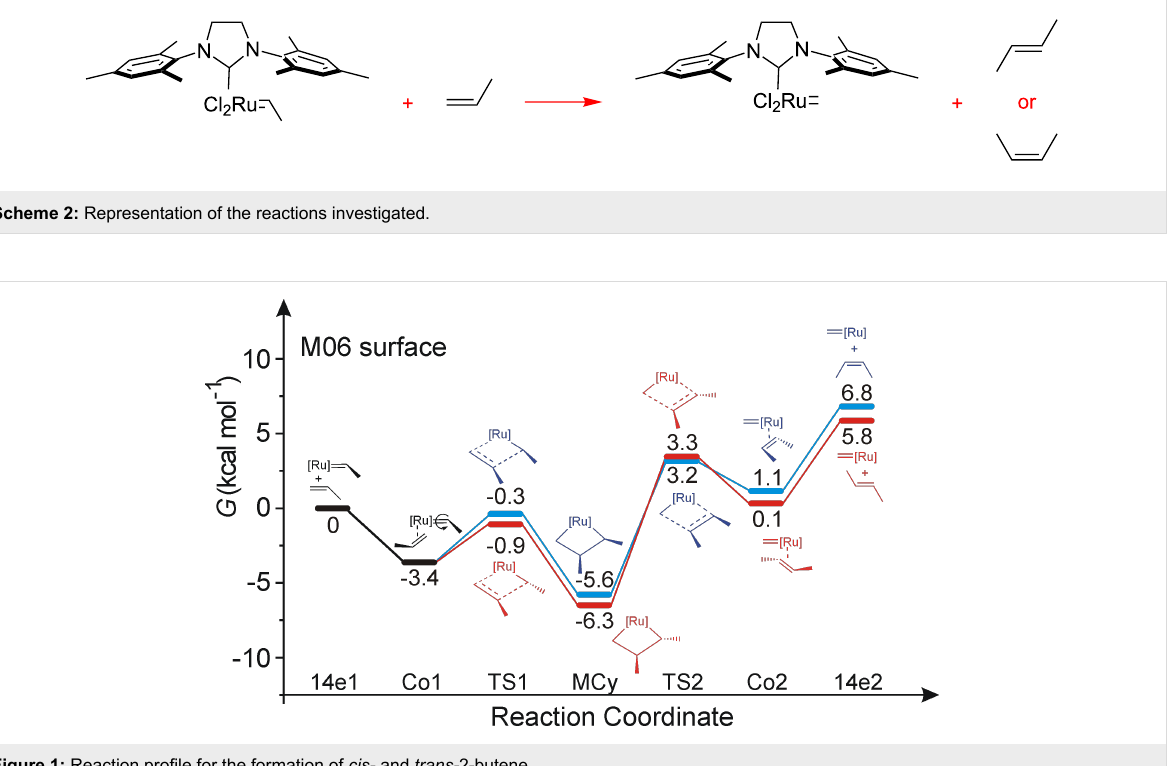
Figure 1: Reaction profile for the formation of cis- and trans- 2-butene.